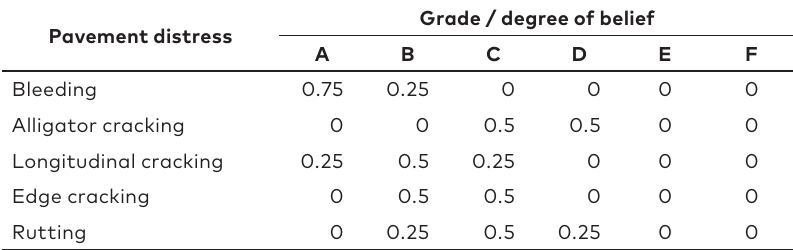
Table 5. Probability assignment of pavement Section 1 to various assessment grades